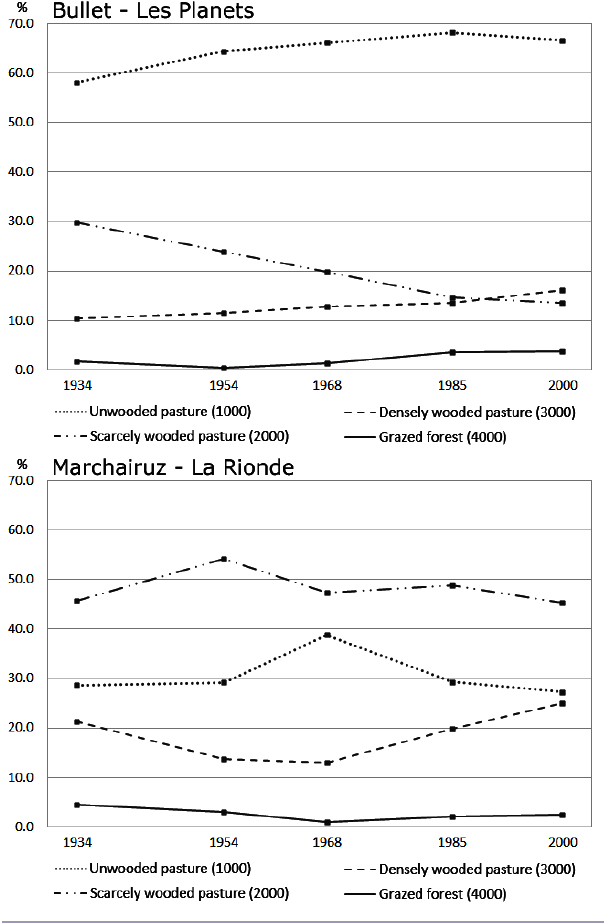
Fig. 6 . Evolution of tree-cover categories between 1934 and 2000 in Bullet and in